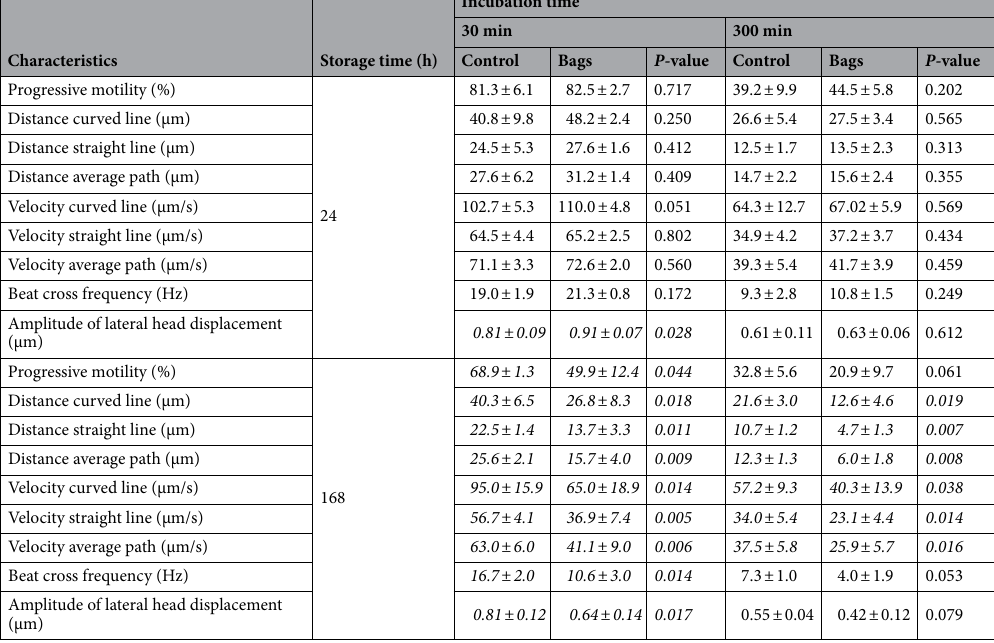
Table 4. Sperm kinematic data of CASA analysis after thermo-resistance test (30 and 300 min at 38 °C) of boar spermatozoa in sixteen pooled ejaculates (4 × 4 ejaculates) from 16 mature Pietrain boars in control and MEDI NOVA bags. Significant differences are marked with